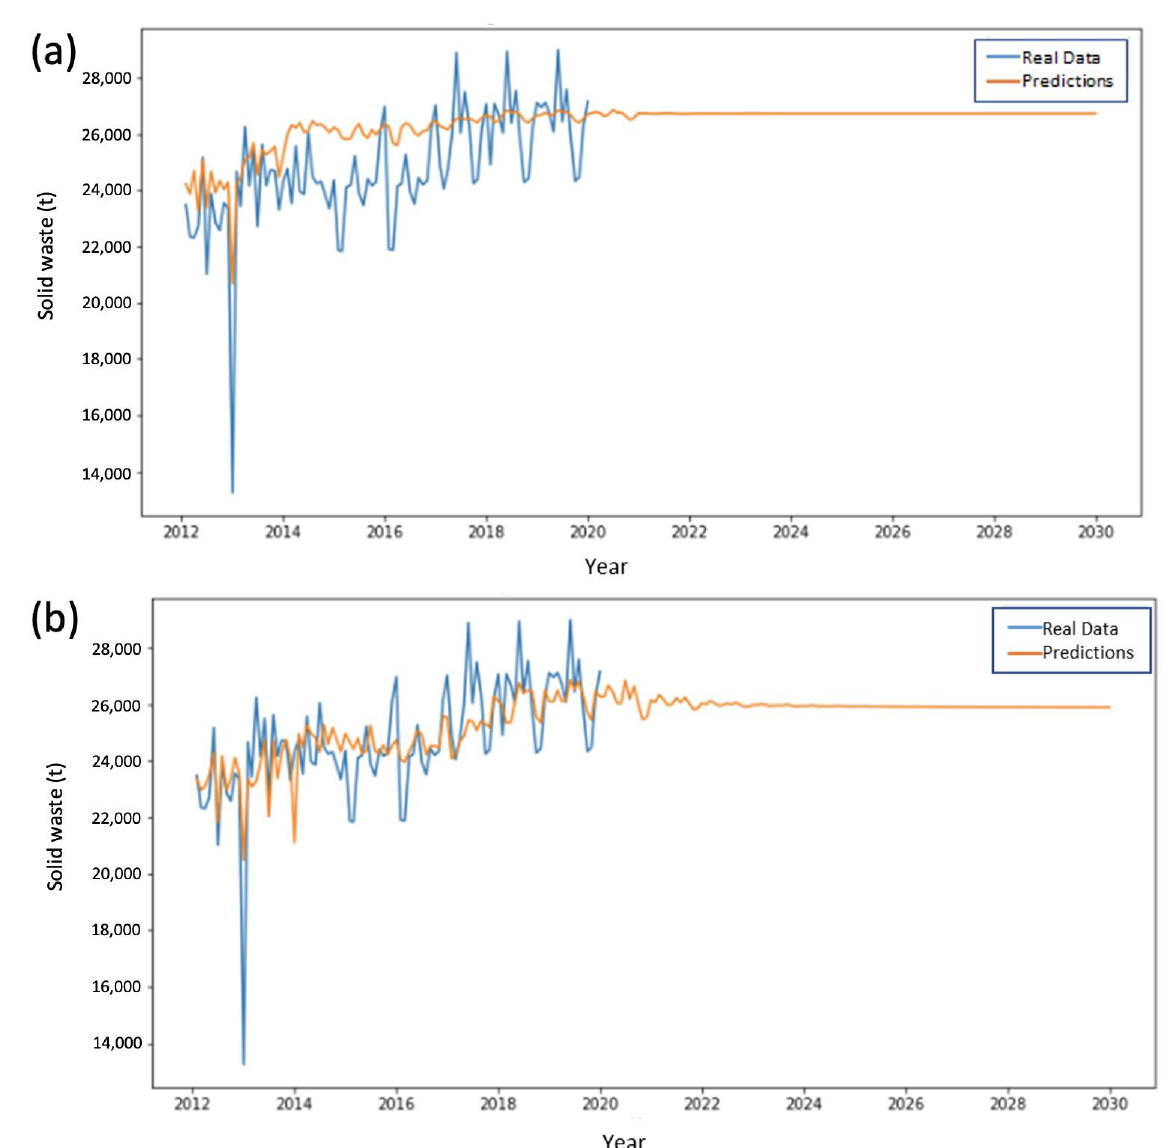
Figure 9. Performance comparison in the training and prediction for ESA Zone 5 using ( a ) LSTM and ( b ) SVMs.